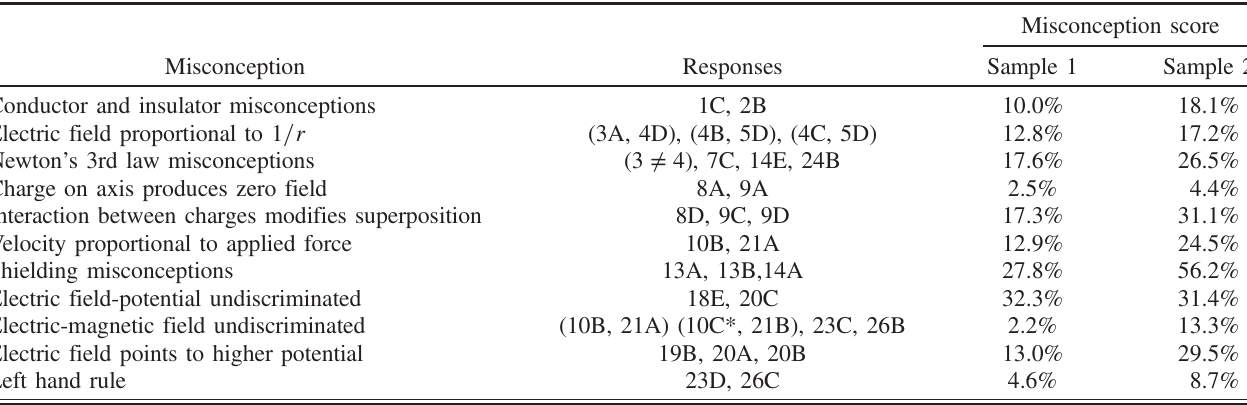
TABLE II. Misconception scores. Items not in parentheses represent independent misconceptions. Items in parentheses represent a misconception only if both items are selected and are counted as one